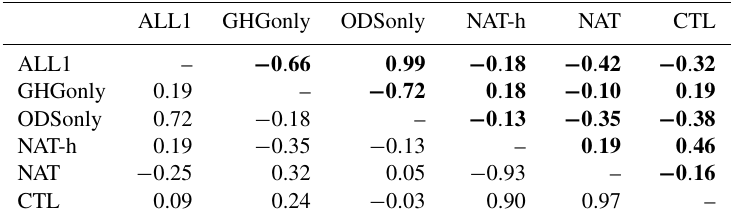
Table 1. Correlation coefficients between the leading signal and noise patterns for the upper stratosphere (bold) and lower stratosphere. Signal patterns are the leading EOFs for ALL1, GHGonly, and ODSonly. The noise patterns are the leading EOFs for NAT-h, NAT, and CTL (see Figs. 5 and 6). ALL1 GHGonly ODSonly